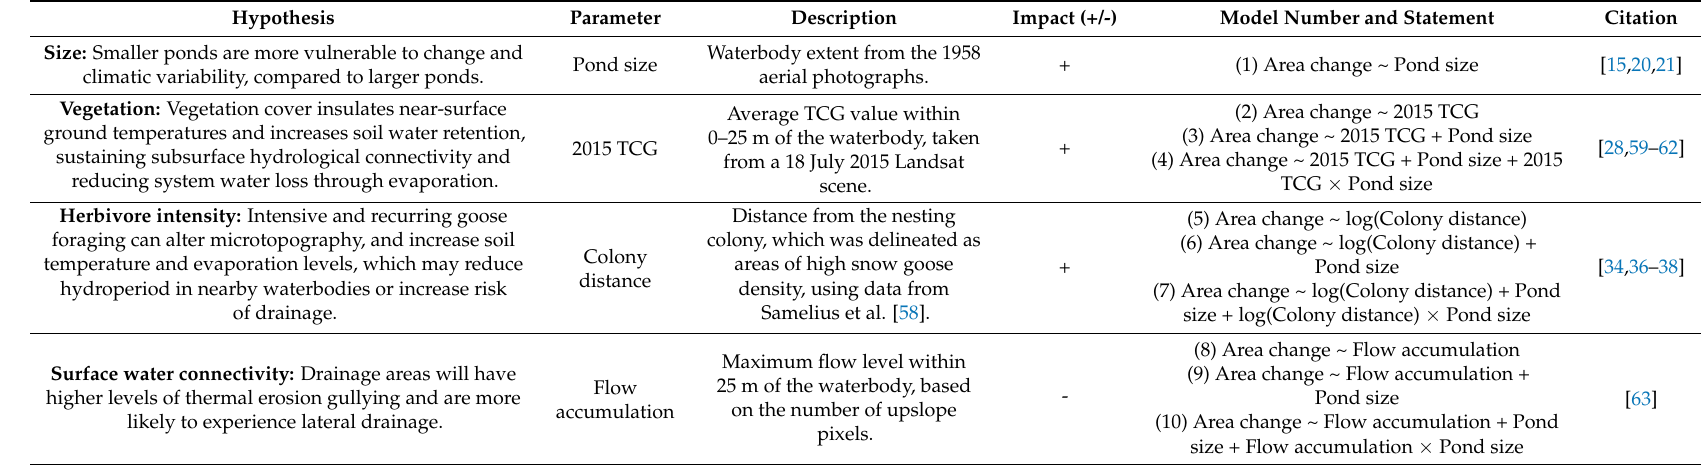
Table 1. Descriptions of the four a priori hypotheses, parameters included, and model statements. The impact column describes the hypothesized direction of the relationship between the listed parameter and waterbody area